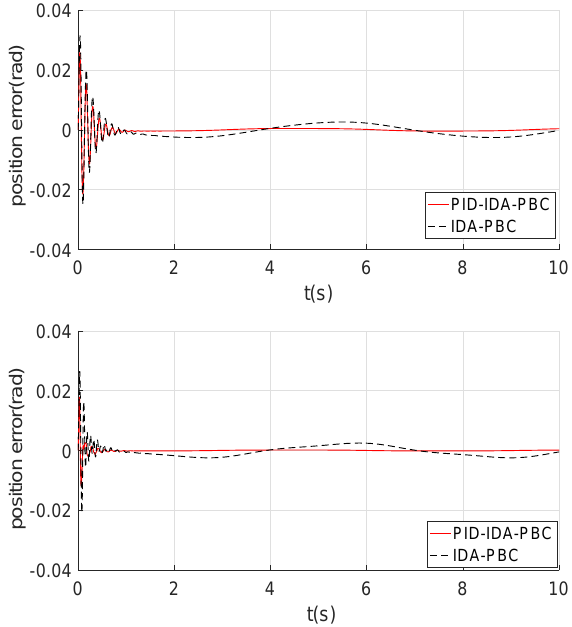
Figure 4. Interconnection and damping assignment passivity-based controller (IDA-PBC) and proportion–integral–derivate (PID)-IDA-PBC position tracking comparison curve.